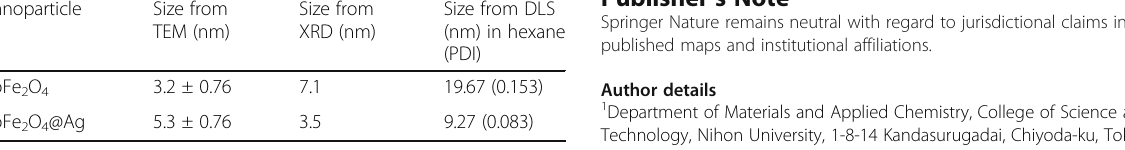
Table 2 Summary of the sizes of NPs obtained from TEM, XRD, and DLS analysis